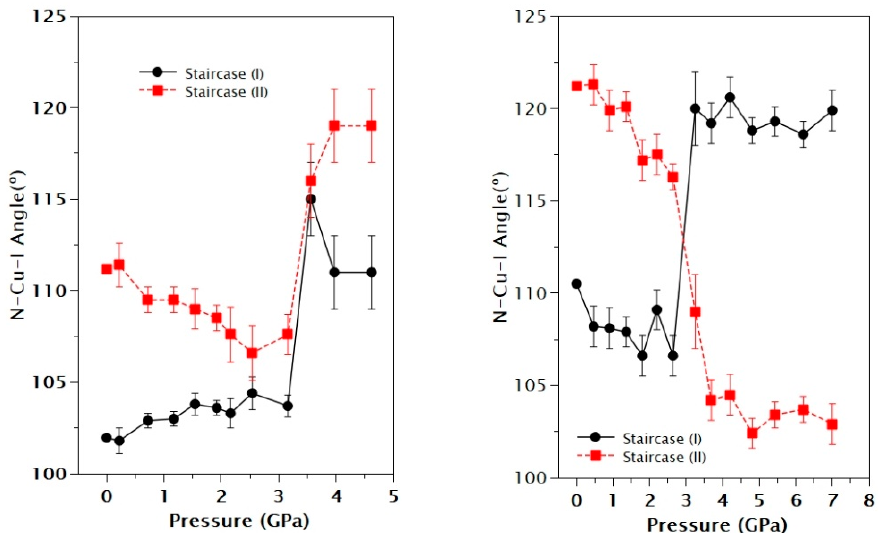
Figure 5. Variation in N-Cu-X (X = Br, I) angles with pressure for [(CuBr 2 (Quin)] ( left ) and [(CuI 2 (Quin)] ( right ). In the right-hand figure, the label ‘Staircase (I)’ corresponds to the Cu1 atoms, while ‘Staircase (II)’ corresponds to the Cu2 atoms.